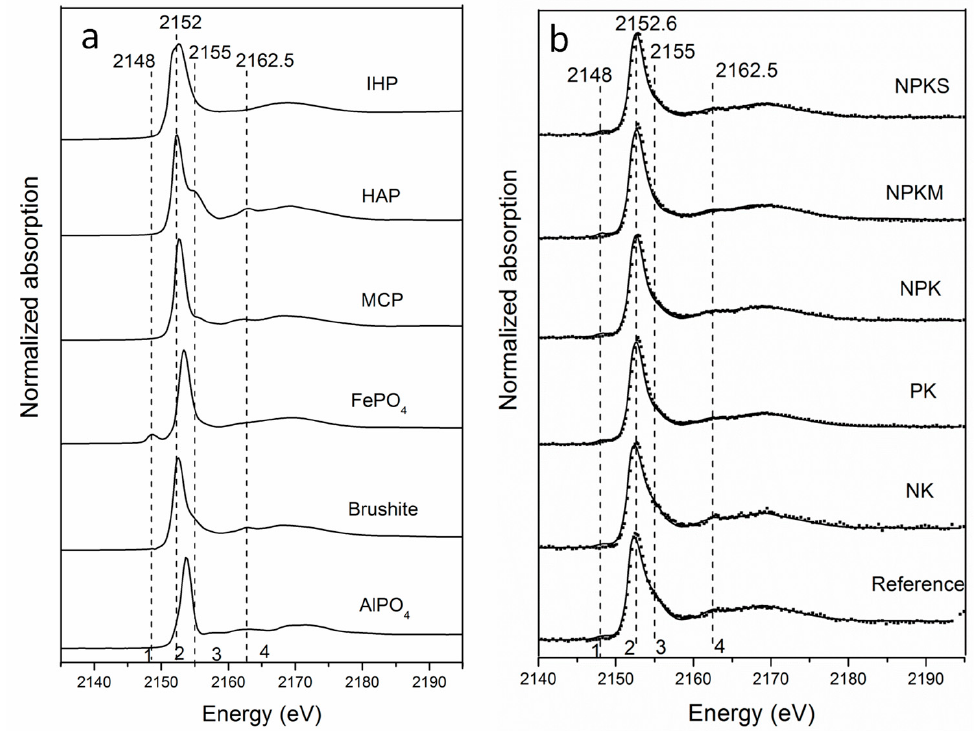
Figure 1. P K-edge XANES spectra of reference ( a ) and soils under different fertilization treatments ( b ). Dash line, experimental data; solid line, fitting data. MCP, monocalcium phosphate. HAP, hydroxyapatite. Table 3. Linear combination fitting of P K-edge XANES spectra of soils under different fertilization treatments.